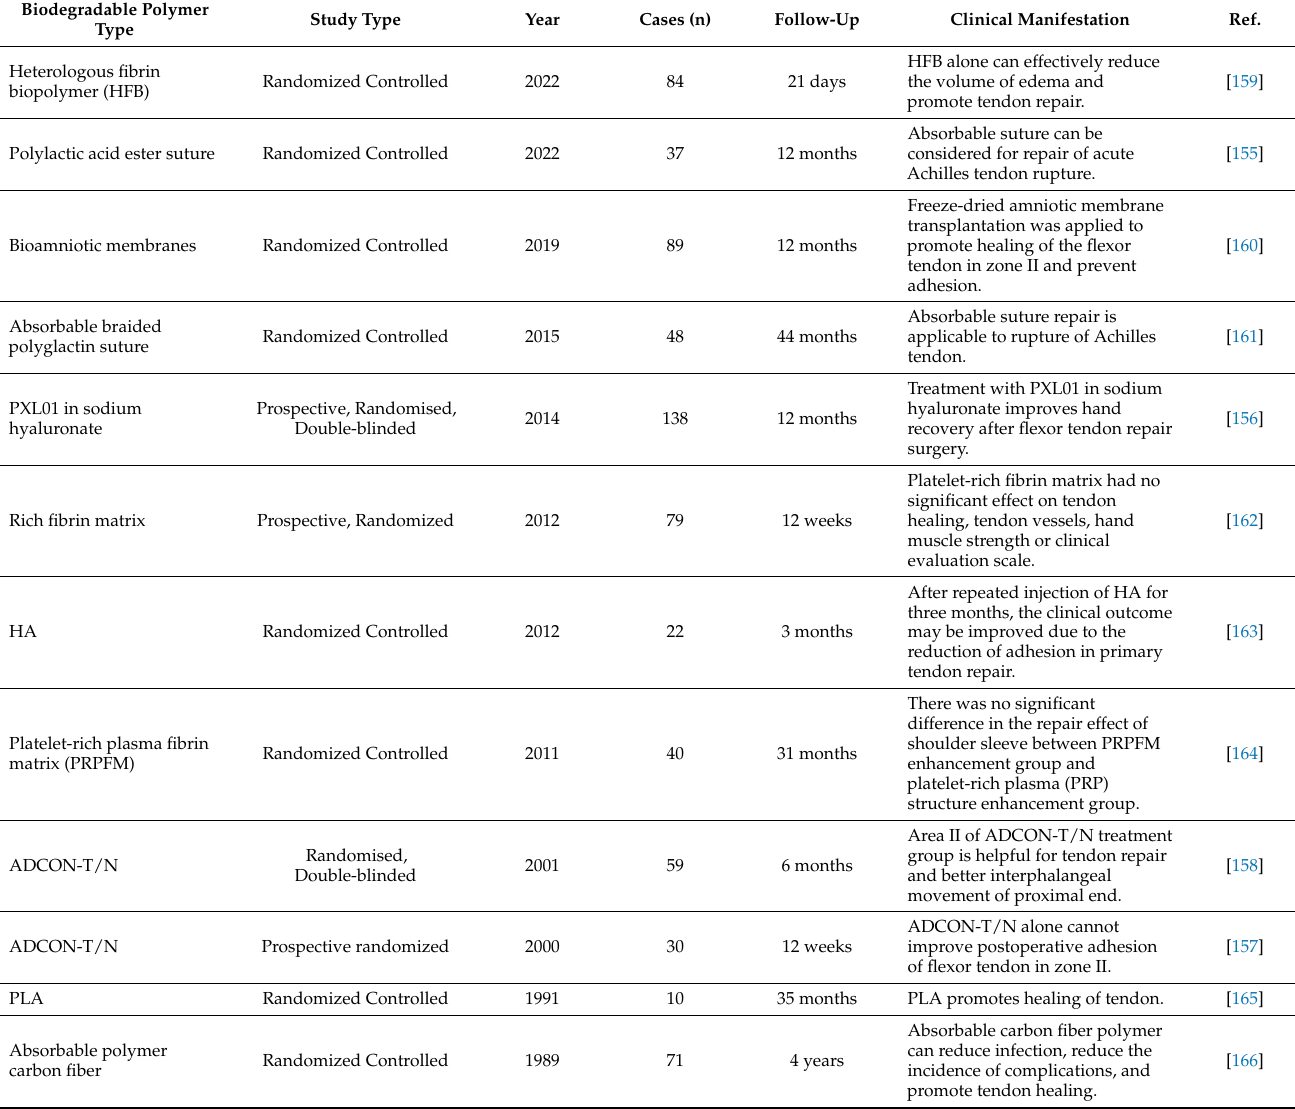
Table 2. Clinical trials of biodegradable polymers in tendon